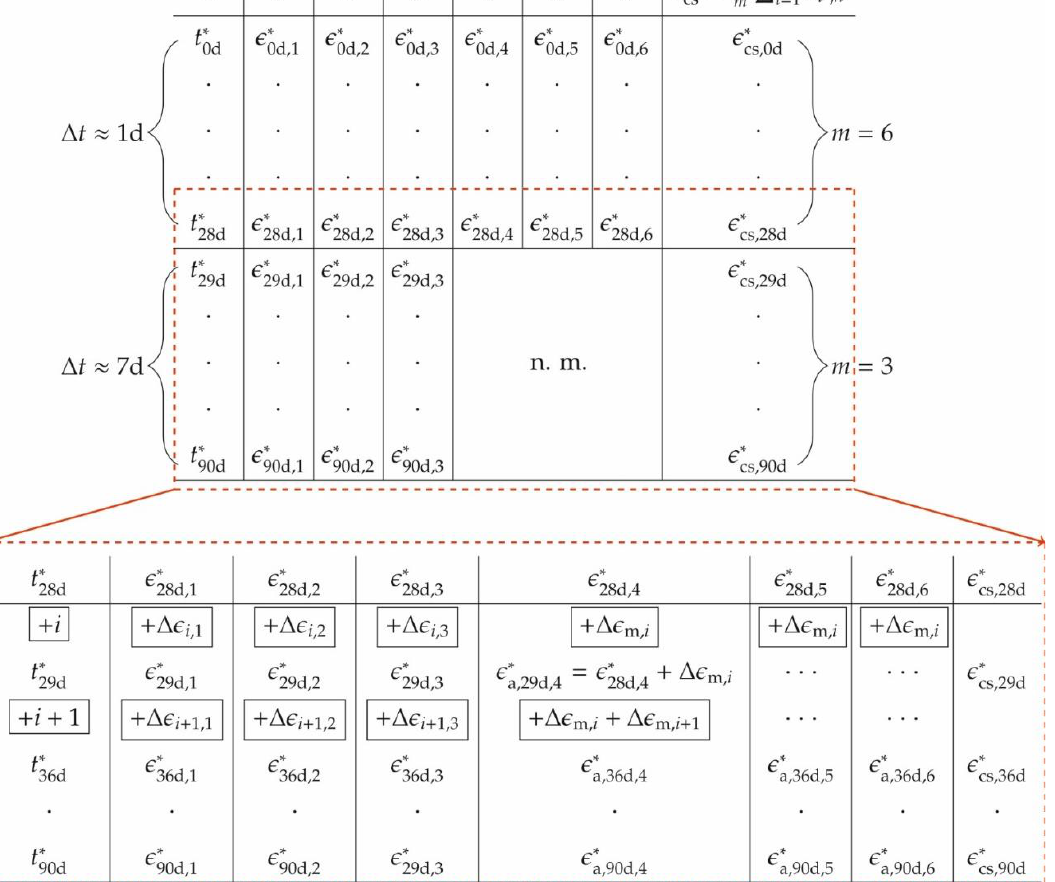
Figure 10. Summary of the shrinkage measurement of ε cs* and the adjustment for t * > 28 d. The adjustment scheme is controlled using the total strains of the beams, since the shrinkage strains were measured up to 90 days for all 6 samples. Therefore, the strains ε t*,4–6* for t > 28 d are set to zero and then interpolated. Figure 11 represents the time course of the shrinkage strain of the beams with and without interpolation of the measured values n = 4–6. Shown are the interpolated (colours) and the measured shrinkage strains (grey, dashed) for T = [0, 1, 2] h (a) and T = [4, 6, 24] h (b). Both curves do almost